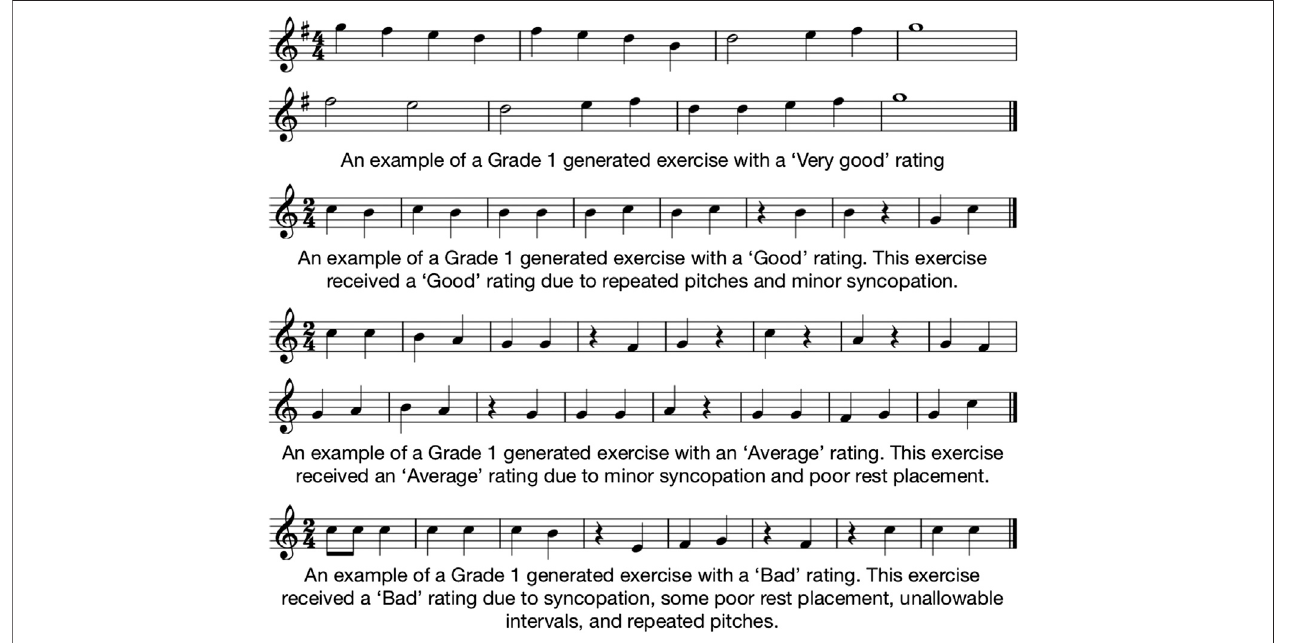
FIGURE6 | Examples ofGrade 1generated exercises assigned each ofthe Likert quality ratings. An example ofan exercise rated as “ Very bad ” isnot provided as none of the Grade 1 exercises were assigned this rating.